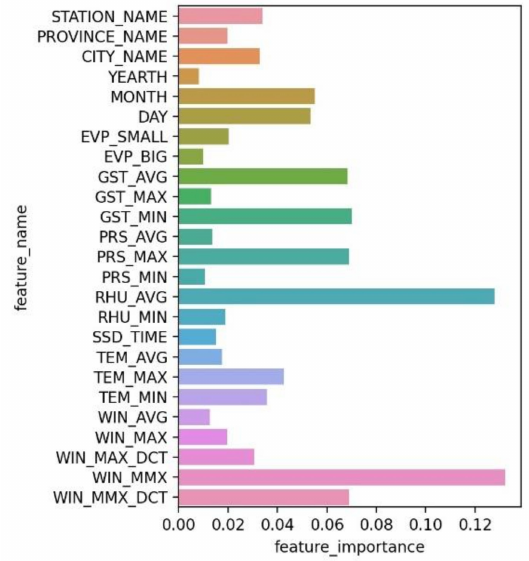
Figure 9. Global importance of each feature.